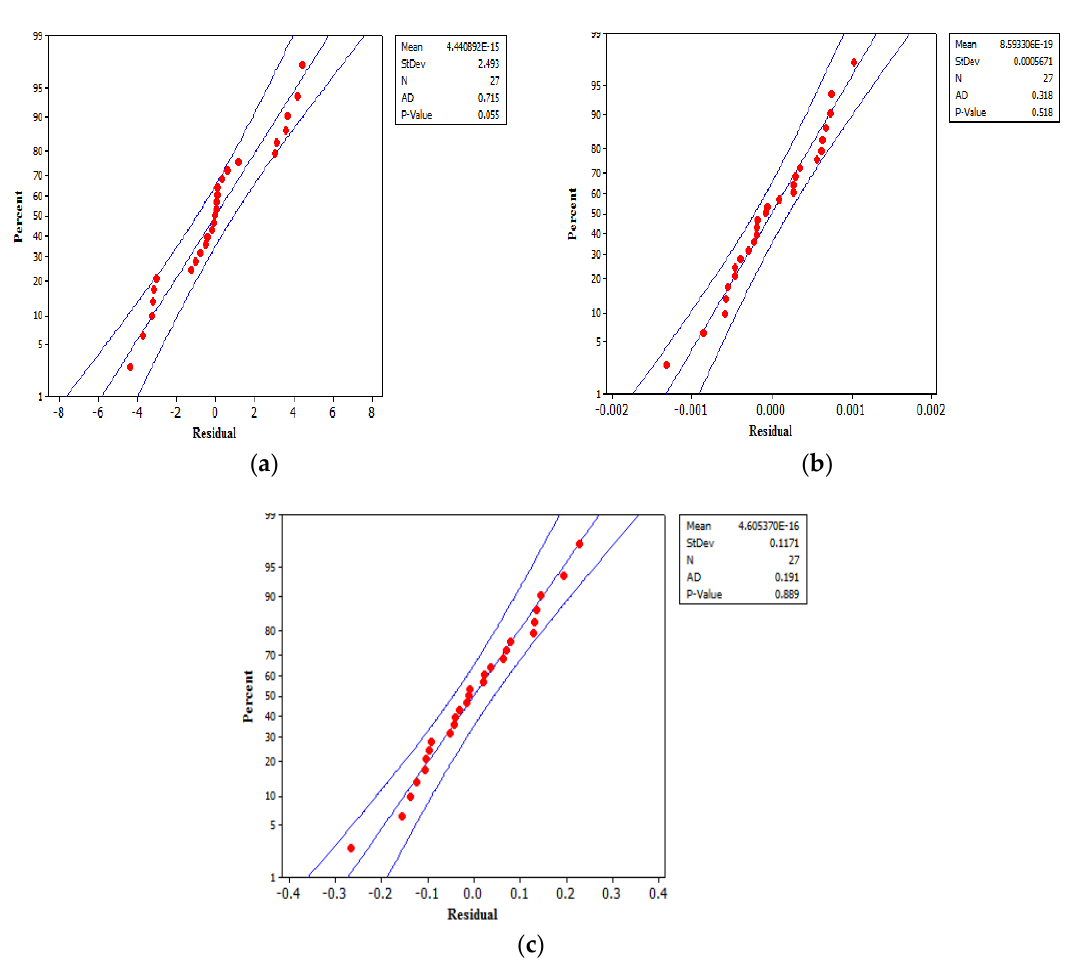
Figure 5. Normality plots for ( a ) MRR ( b ) TWR and ( c ) R a .